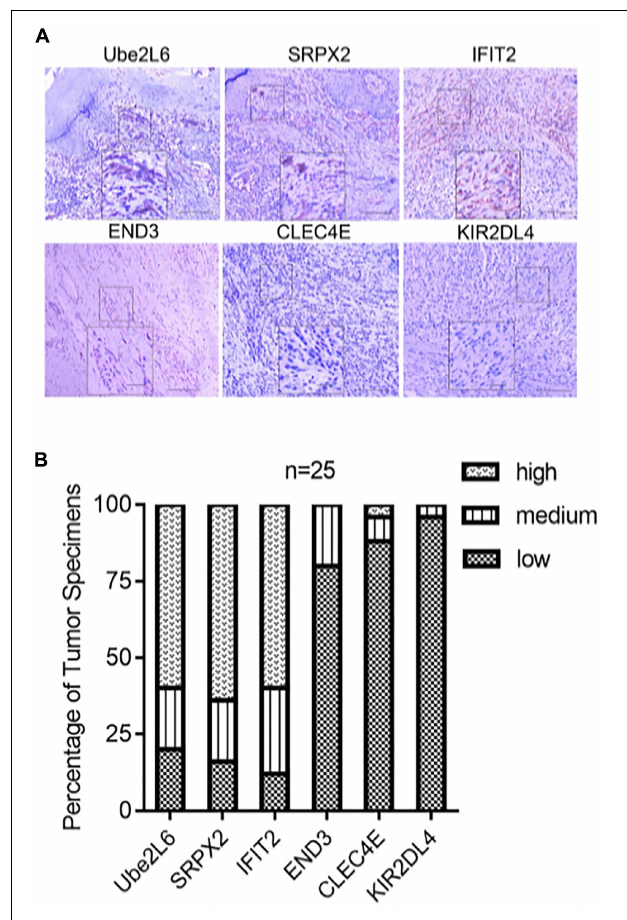
FIGURE 9 | (A) Pictures of inmunohistochemical staining of Ube2L6, SRPX2, IFIT2, END3, CLEC4E, and KIR2DL4. (B) Higher expressions of Ube2L6, SRPX2, and IFIT2 were presented, while lower expressions of CLEC4E, END3, and KIR2DL4 were shown in melanoma tissues ( n = 25) by IHC